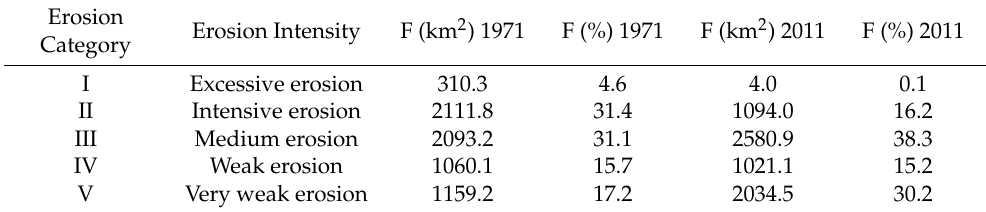
Table 4. Erosion category 1971 and 2011 in the Velika Morava River